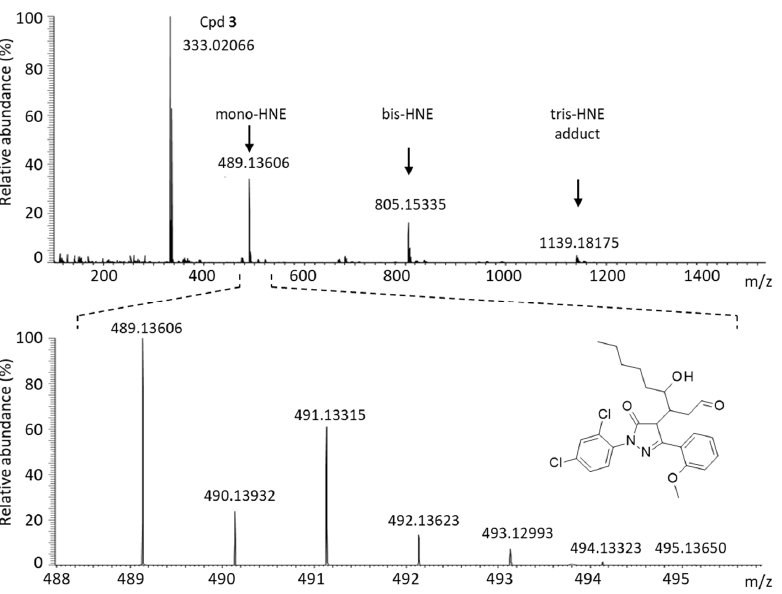
Figure 10. Identification of the covalent adducts formed upon reaction of compound 3 with 4-HNE by HRMS analysis. (Top spectrum) The unreacted parent product ( 3 ) and the different mono-, bis-, and tris-adducts are identified after 3 h of reaction in aqueous buffer (phosphate buffer 10 mM pH = 7.4, with stirring for 180 min at 37 °C). (Bottom spectrum) A detailed analysis of the 488–496 m / z range, corresponding to the mono-adduct (structure indicated).